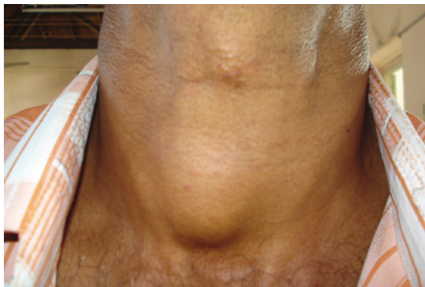
Figure 1: Preoperative photo showing the swelling in front of the neck.